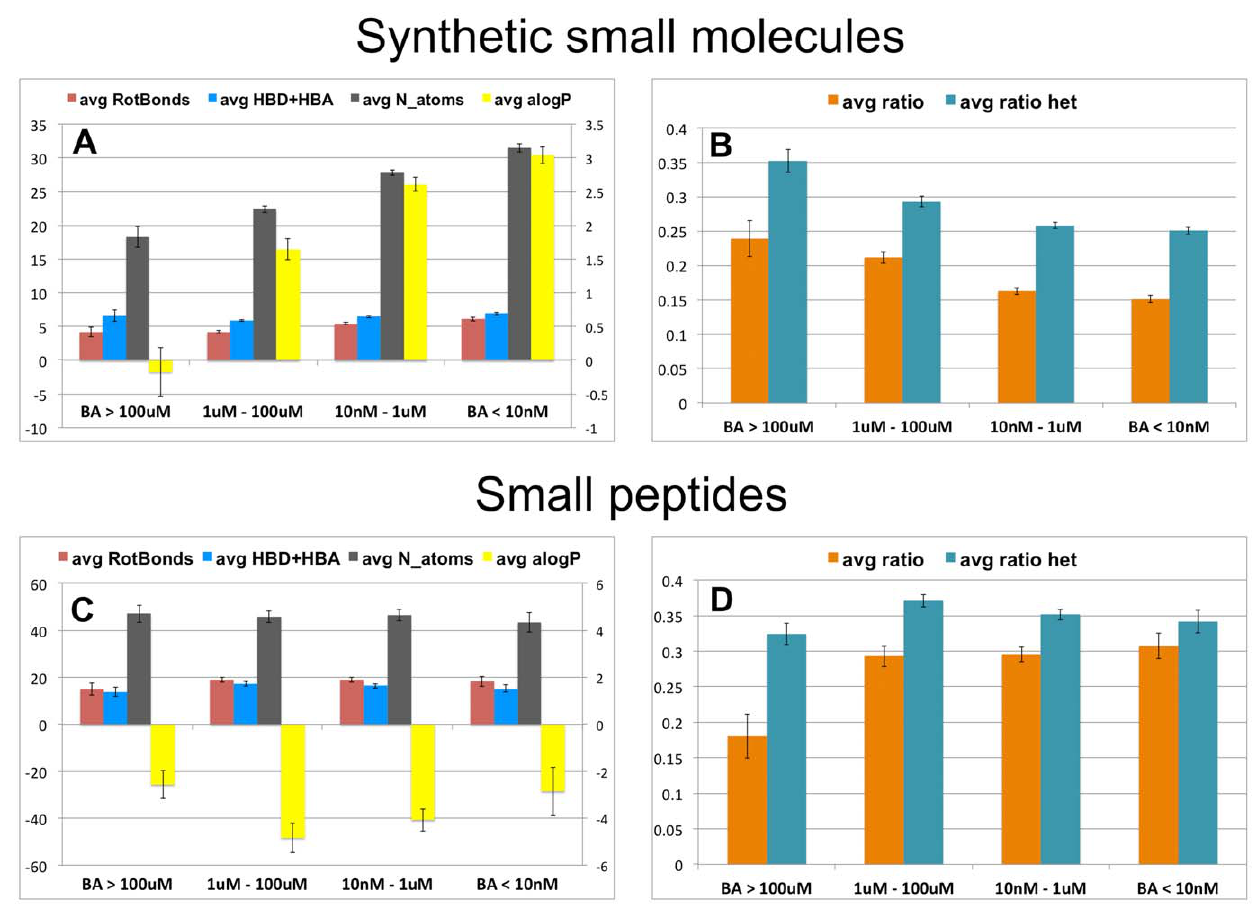
Figure 5. Binding affinity versus interaction profile. Binned binding affinity (BA) data for synthetic small molecules (A and B) and for small peptides (C and D). Bars in (A) and (C) denote the average of molecular properties for each affinity bin: rotatable bonds (red), sum of hydrogen bond donors and acceptors (blue), number of atoms (black) and AlogP (yellow, in the secondary right axis scale for clarity). Bars in (B) and (D) denote the average of polar ratio (orange) and the average heteroatom content (cyan). Error bars are the standard error of the mean.